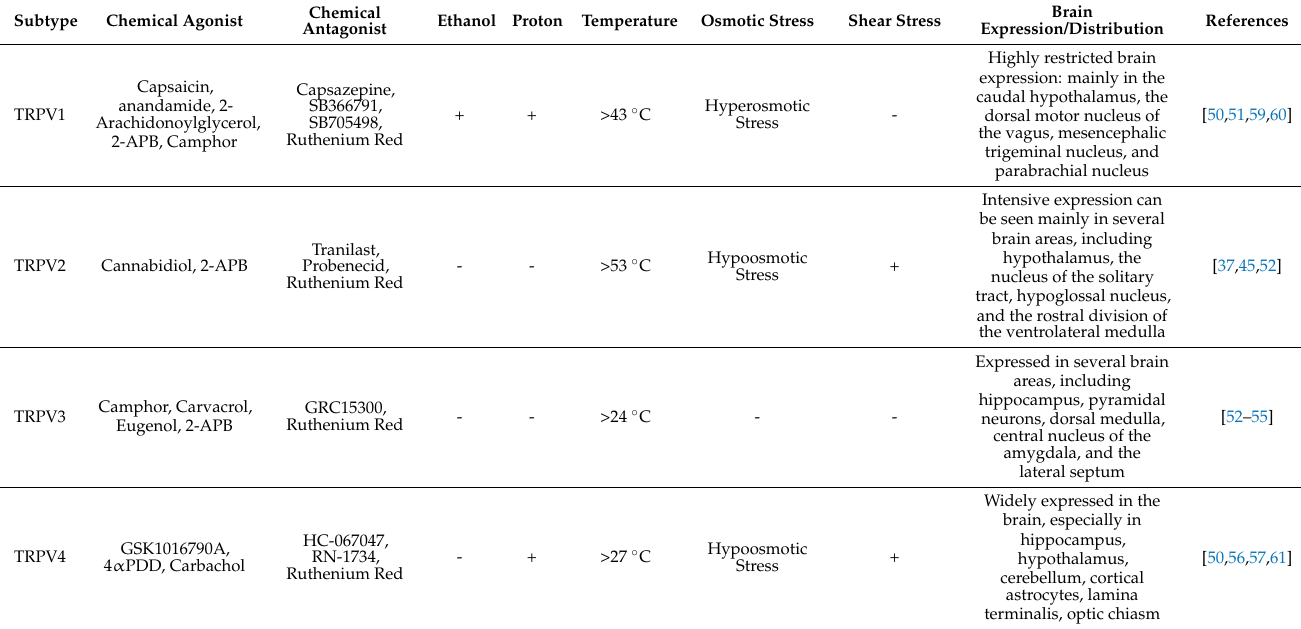
Table 2. Overview of TRPV1–4 brain expression and